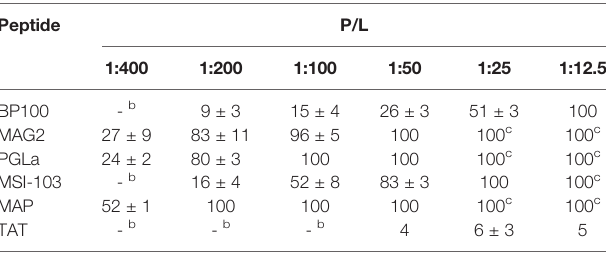
TABLE 3 | Vesicle leakage (in %) induced by the tested peptides in POPC/ POPG (1:1) vesicles at different P/L values.